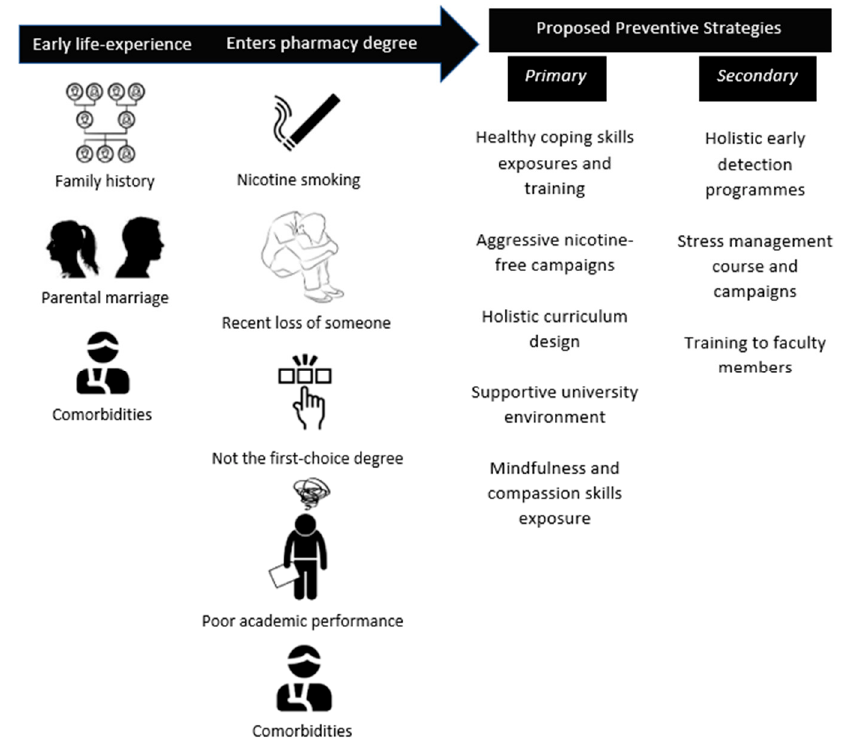
Figure 1. Factors associated with depression symptoms and proposed preventive strategies.